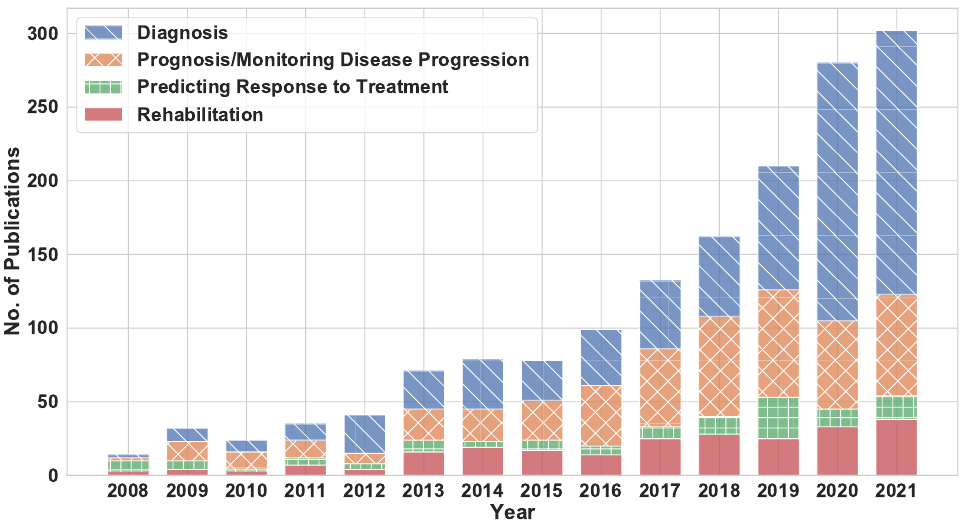
Figure 4. The yearly publication trends between 2008 and 2021 in each application area.